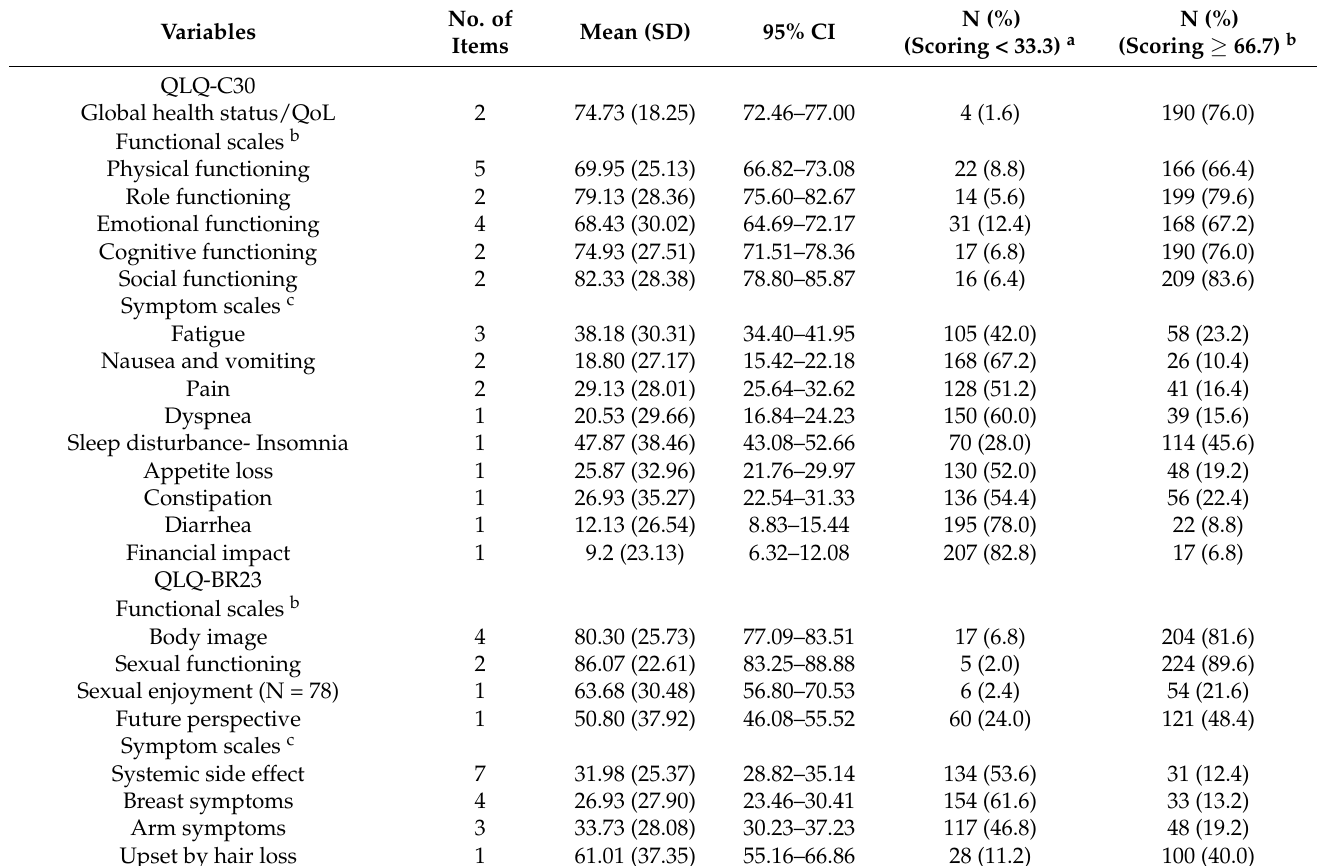
Table 2. Mean scores for all items on the QLQ-C30 and QLQ-BR23 (N =